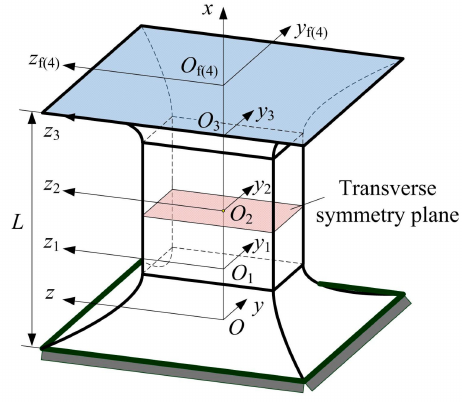
Figure 5. Geometric relationships among coordinate